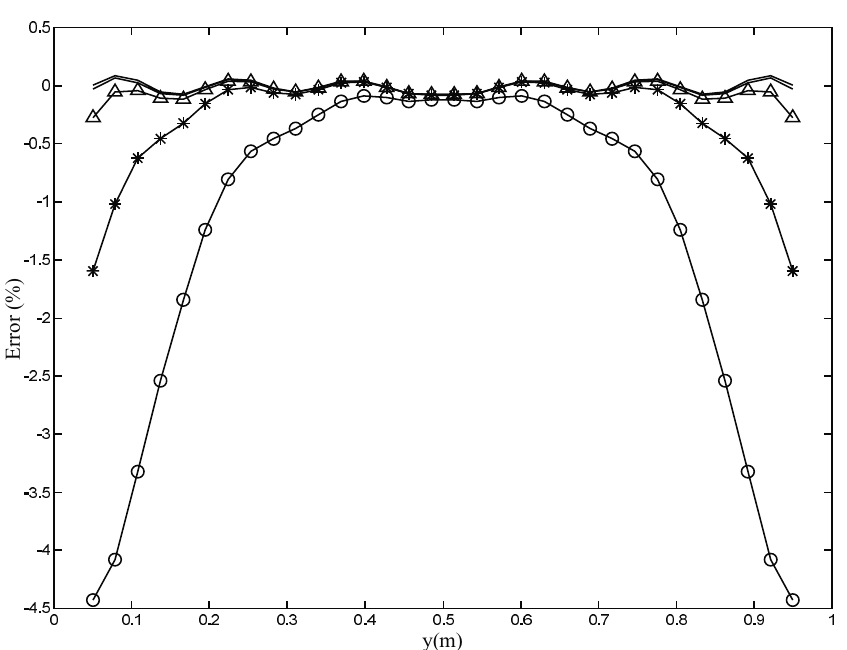
Fig. 8. Comparison of the errors between EFA analytic solution and direct EFBEM solution along the representative line with changing the number of boundary elements when f = 10 kHz and η = 0 . 05 : , 8 boundary elements; , 16 boundary elements; , 32 boundary elements; - - -, 64 boundary elements; —, 128 boundary